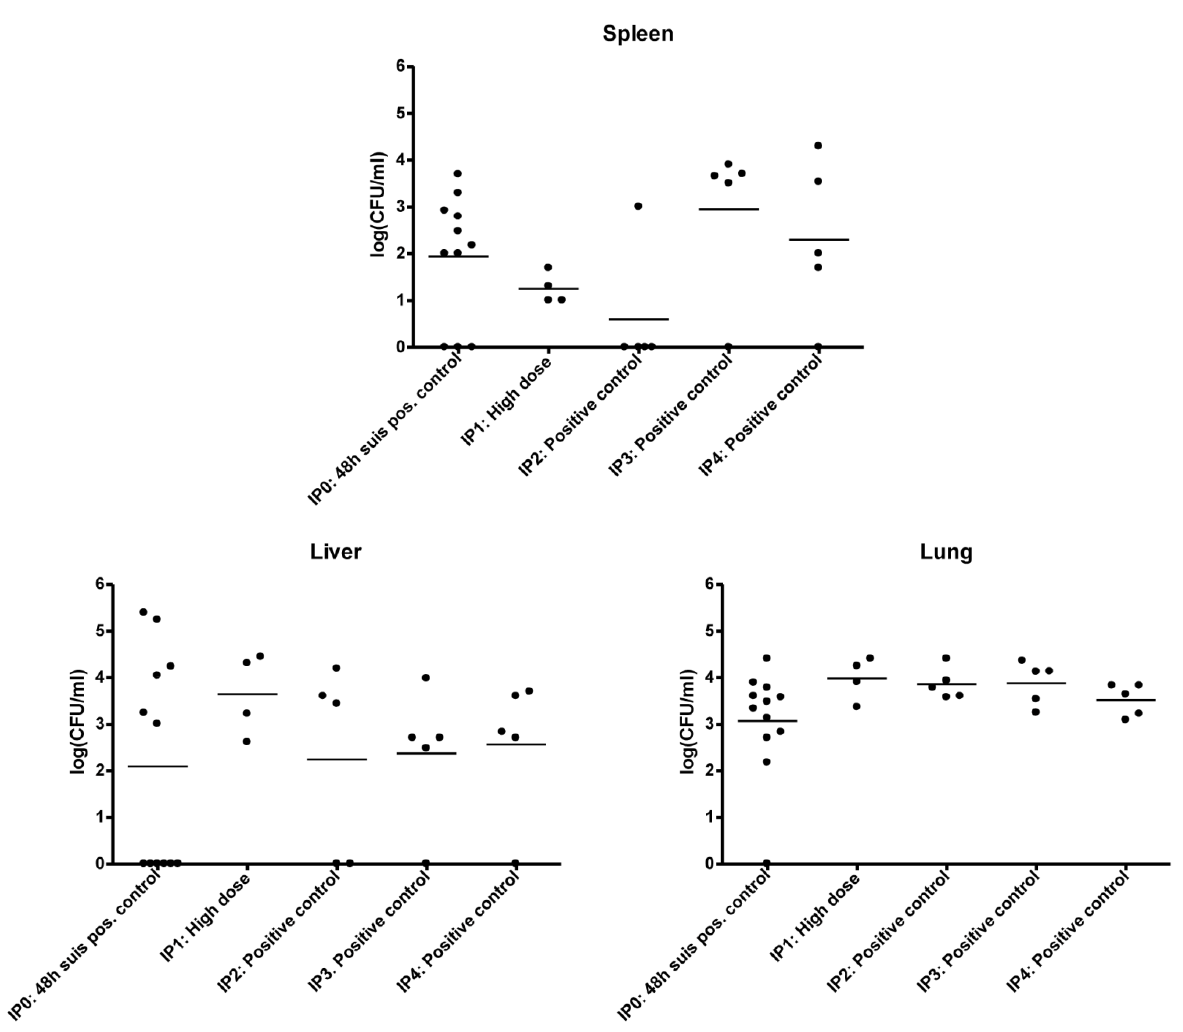
Figure 2. Comparison of positive controls, i.e. , without treatment and inoculated with 10 7 CFU/mL S. suis 12915 from mouse experiment